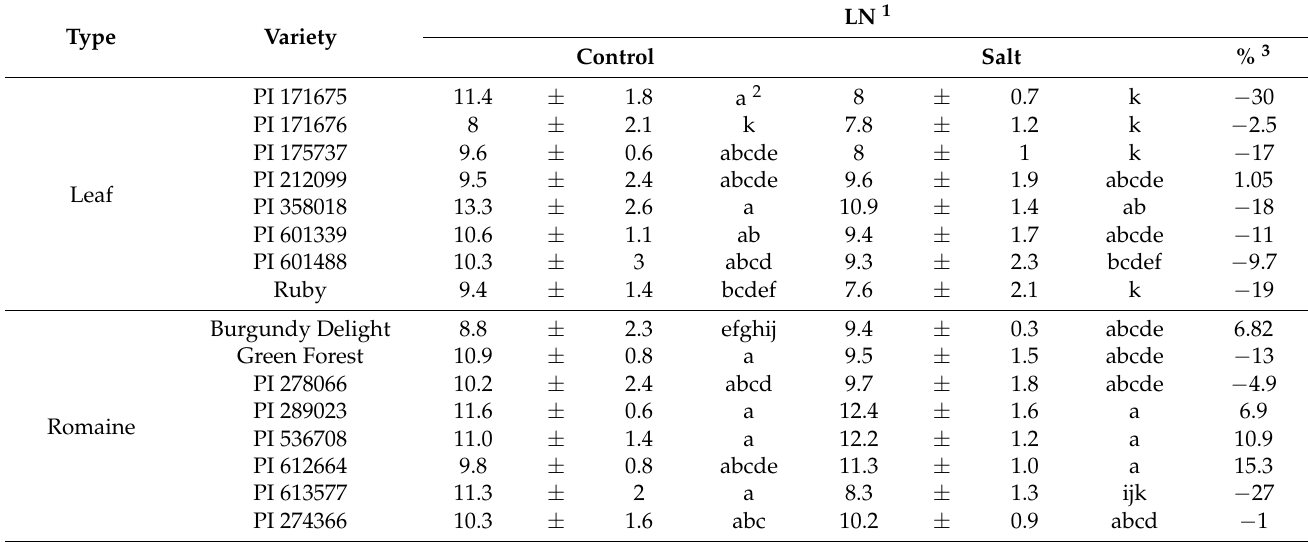
Table 2. Leaf number (LN) (mean ± standard deviation, n = 6) of leaf- and romaine-type lettuce cultivars grown under control and salt-stress conditions (100 mM) after 42 days of sowing (10 days after salt